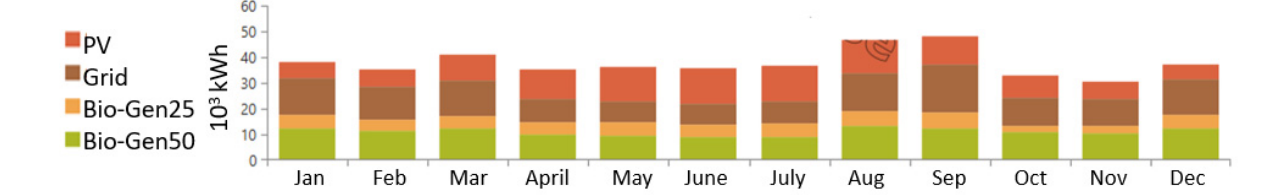
Figure 5. Monthly distribution of the hybrid energy system ’ s average power generation.